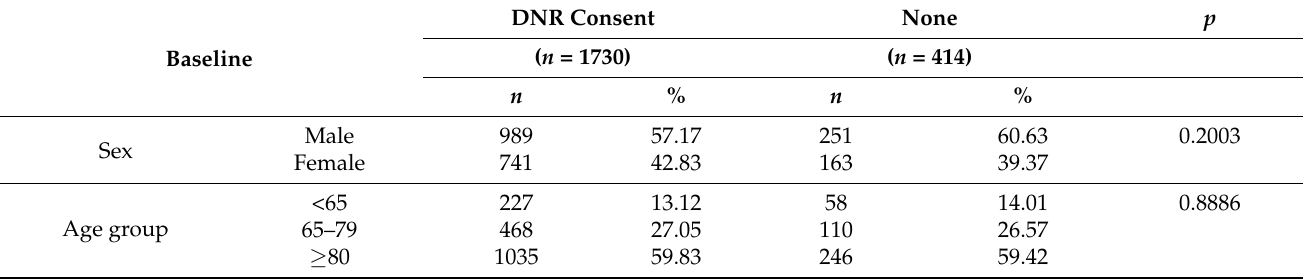
Table 2. DNR status from 1 January to 31 December 2018, in Taipei City Hospital HIS (N = 2144).